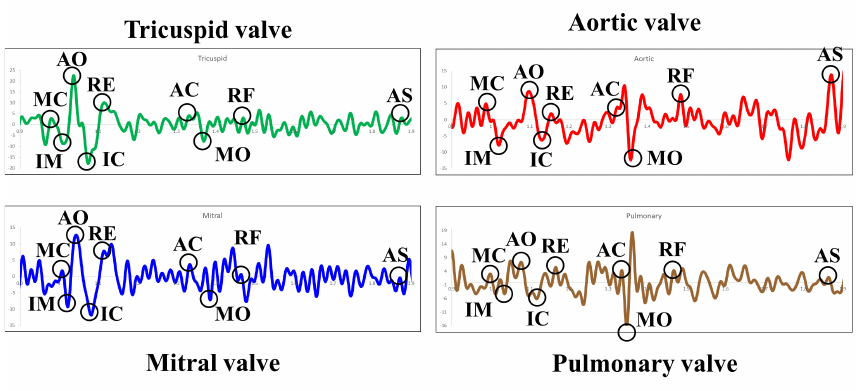
Figure 10. Feature points of multi channel SCG